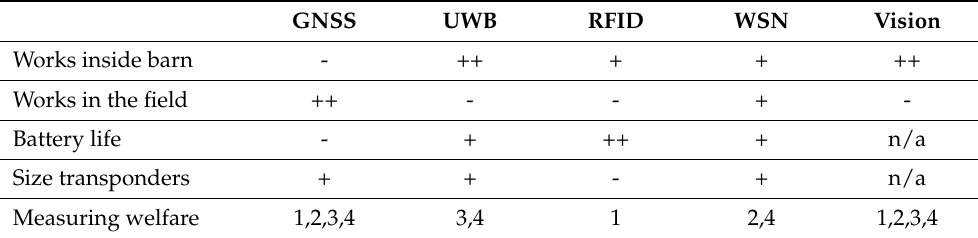
Table 1. Comparison of current location determining techniques used for cattle and details of the research conducted to date in relation to the Welfare Quality